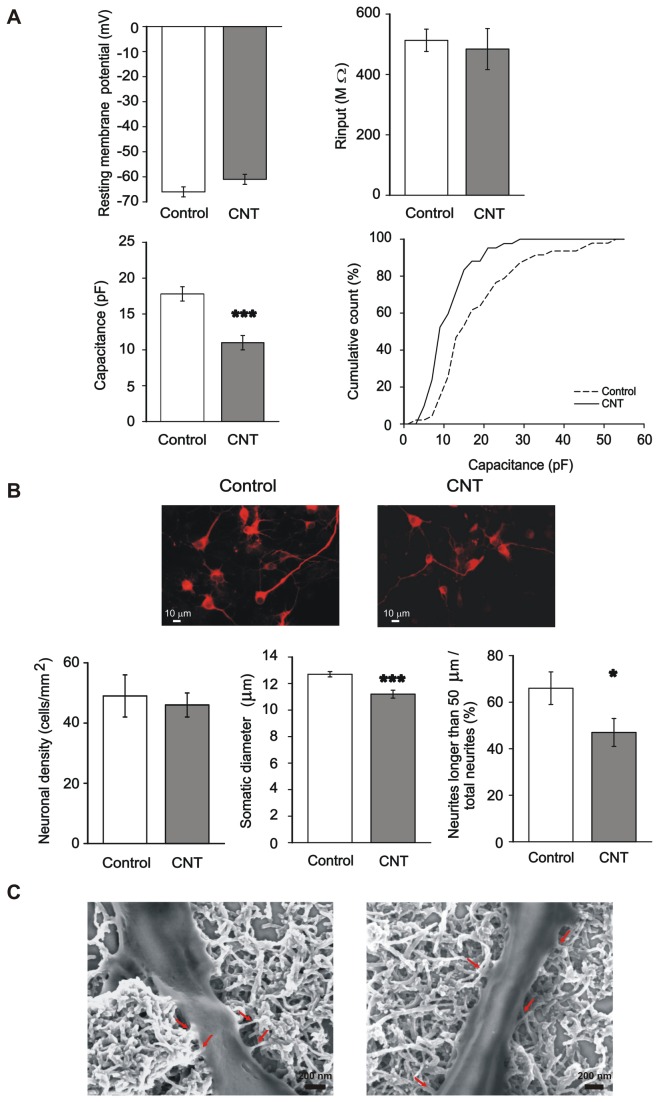
Carbon nanotubes substrate selectively affects membrane properties and neurite extension of spinal neurons.(A) Spinal neurons grown on MWCNT show similar resting potential and membrane resistance (Rinput) with respect to control neurons (top), while membrane capacitance, indicative of total cell membrane extension, is significantly lower in CNT neurons (bottom left, ***: P<0.001; bottom right, cumulative distribution, KS test: P<0.01). (B) Top, typical examples of spinal cord neurons cultured in control condition or on MWCNTs, labeled with the antibody against the neuronal marker β-tubulin III to visualize neuronal morphology. Bottom, despite a similar neuronal density (left), CNT cultures showed a slightly, but significantly lower somatic neuronal diameter compared to control cultures (middle; ***: P<0.001), together with a lower number of long neurites (right; *: P<0.05). These findings are in agreement with the lower membrane capacitance values found in CNT neurons. (C) SEM images of neurites from spinal neurons grown on a MWCNT layer, showing the numerous and very tight contacts between MWCNTs and neuronal membranes (red arrows).